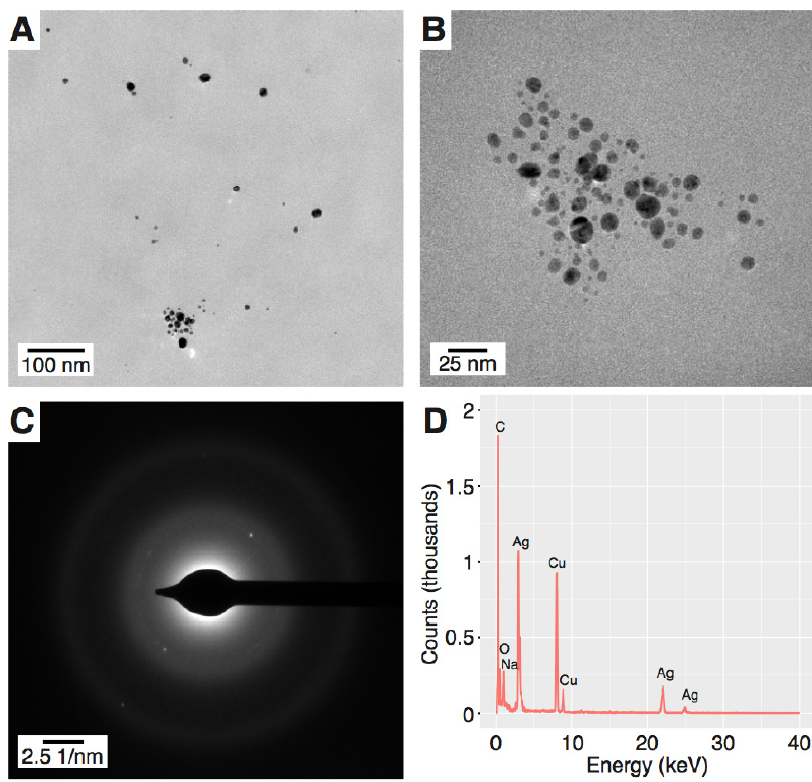
Figure 2. Morphology of the produced PEC-silver nanoparticles (AgNPs). ( A , B ) Representative transmission electron microscopy (TEM) images; ( C ) the selected-area electron diffraction (SAED) pattern; and ( D ) the energy dispersive X-ray spectroscopy (EDX) spectrum.